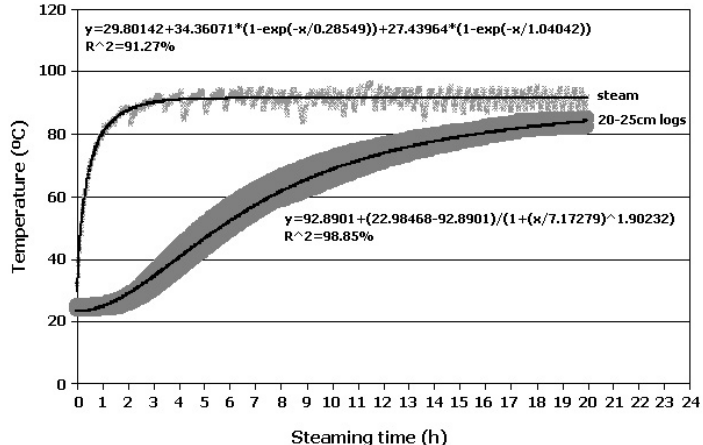
Fig. 2 – Logistics S-shaped curve adjusted for the temperature in the Eucalyptus grandis logs center classified between 20 and < 25 cm diameter during steaming.